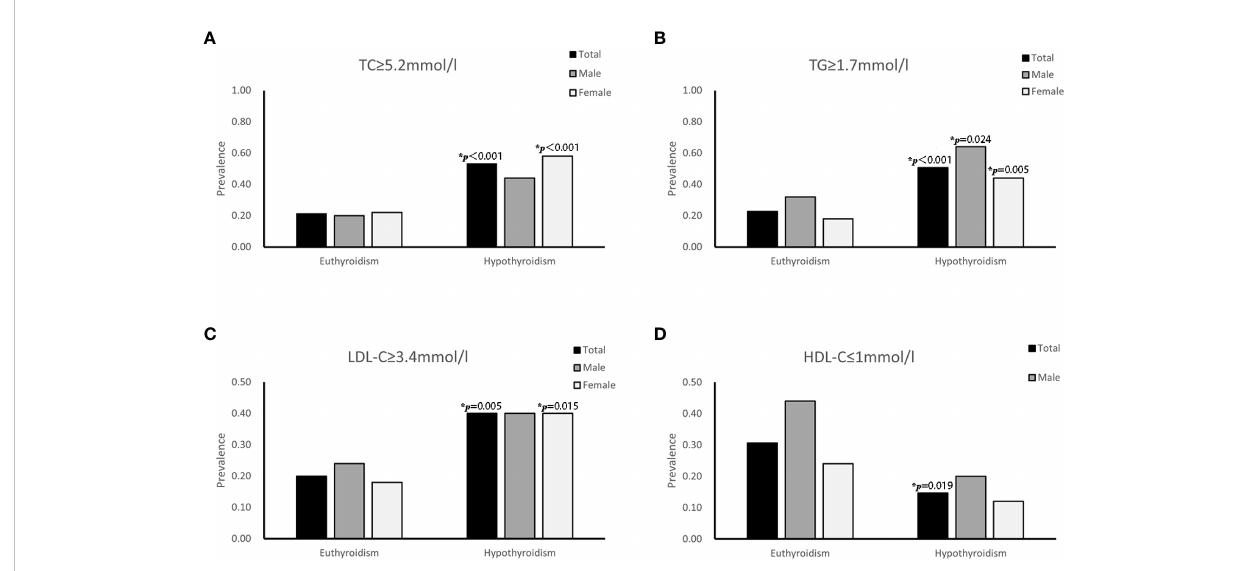
FIGURE 1 Serial changes in the proportion of patients with dyslipidemia associated with euthyroidism and hypothyroidism in patients with DTC who received radioactive iodine ablation following total thyroidectomy. Prevalence of (A) hypercholesteremia (TC ≥ 5.2mmol/l), (B) hypertriglyceridemia (TG ≥ 1.7mmol/l), (C) high low-density lipoprotein-cholesterol (LDL-C ≥ 3.4mmol/l) and (D) high-density lipoprotein-cholesterol